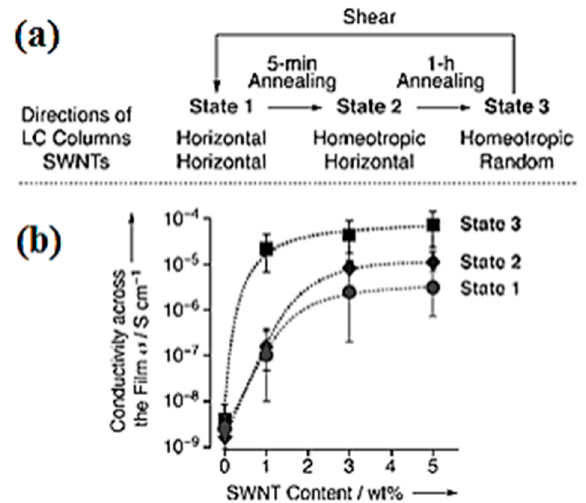
Figure 5. ( a ) Processing and orientational characteristics of states 1–3. ILC col /SWNT composites were sheared (state 1), shortly annealed for 5 min at 150 °C (state 2) and then annealed for 1 h at 150 °C (state 3). ( b ) Plots of conductivities across the film (s) of states 1–3 at 258 °C of ILC col films doped with 0, 1, 3 and 5 wt% SWNTs, sandwiched by ITO electrodes with a separation of 12.5 μ m. Reproduced with permission [98].